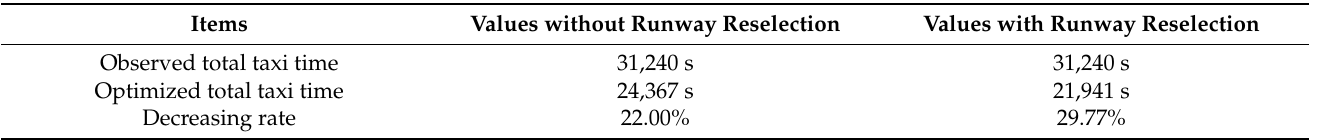
Table 3. Decreasing rate of total taxi time.